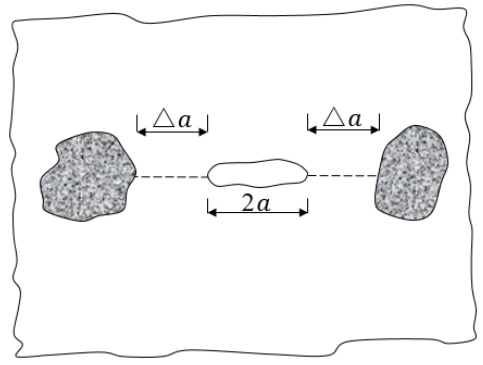
Figure 15 . Schematic of a crack encountering an aggregate after propagating a distance a  . Figure 15. Schematic of a crack encountering an aggregate after propagating a distance ∆ a